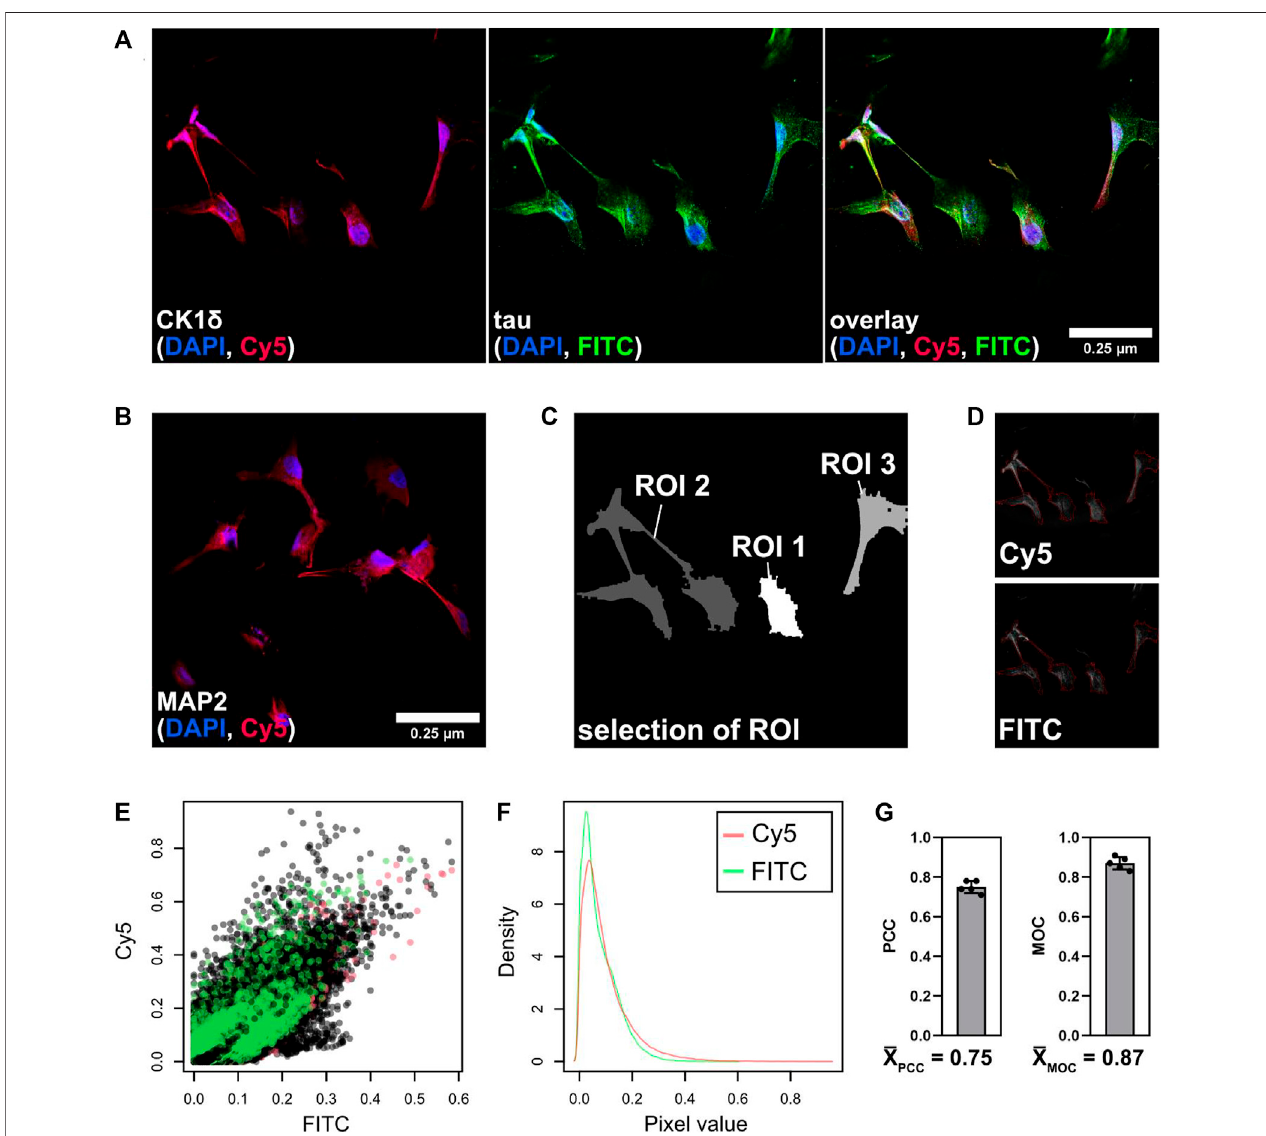
FIGURE 6 | Co-localization of tau and CK1 δ in neuronal cells. Immuno fl uorescence was performed with differentiated human neuronal cells. (A) Cells were fi xed and stained withDAPI (blue, nuclei), anti-CK1 δ goat antibody/Alexa Fluor647 anti-goat antibody (Cy5/red, CK1 δ ) and anti-tau mouse antibody/DyLight488anti-mouse antibody (FITC/green, tau). (B) Differentiation level was examined by staining of neuron-speci fi c marker MAP2. Images were taken at ×63 magni fi cation using the Leica SP8confocalmicroscope(LeicaMikrosystemeVertriebGmbH,Wetzlar,Germany).Scalebar:0.25 µm. (C,D) Mergedimageswereprocessedandanalyzedusing R according to Ahmed et al.(2019). (C) Low-resolution image (pixel set) of the merged image with selected ROIs. (D) Selected ROIs are highlighted (red line) within both channels(Cy5,FITC). (E) Rawpixelintensities ofboth channels(Cy5,FITC) fromthree selectedregions(showninblack, green, andred). (F) Density ofthepixelvaluesof bothchannels(Cy5(red)andFITC(green))fromsummarizedROIs. (G) AnalysisofPCCandMOCaccordingto(Ahmedetal.,2019)( n =5).Valuesaregivenasmeanand error bars represent the standard deviation. MOC: Mander ’ s overlap coef fi cient, PCC: Pearson ’ s correlation coef fi cient, ROI: region of